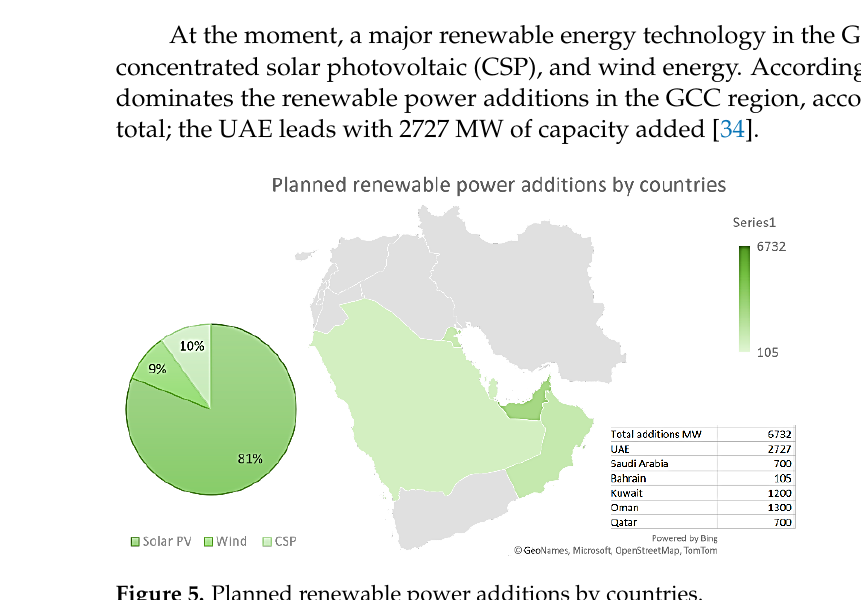
Figure 5. Planned renewable power additions by countries.